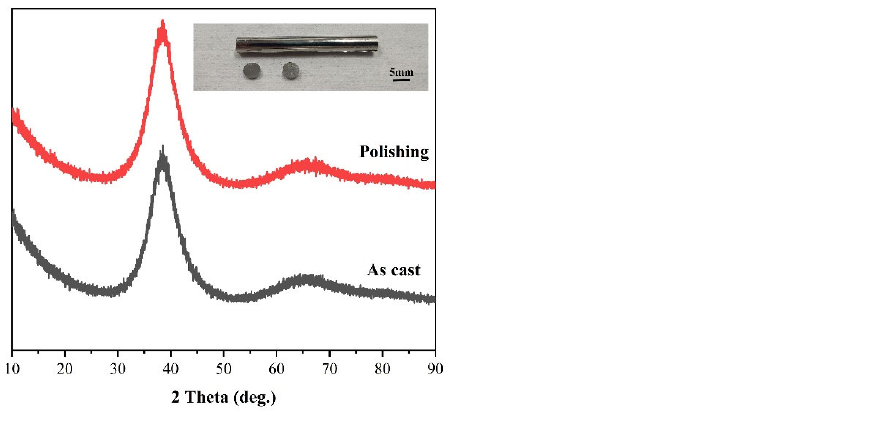
Figure 3. X-ray diffraction patterns of the Zr 48 Cu 36 Ag 8 Al 8 sample before (black) and after (red) polishing.